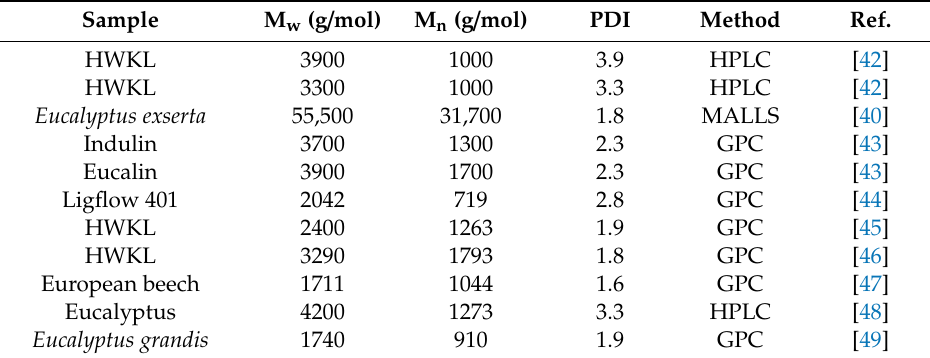
Table 3. Molecular weight distribution of hardwood kraft